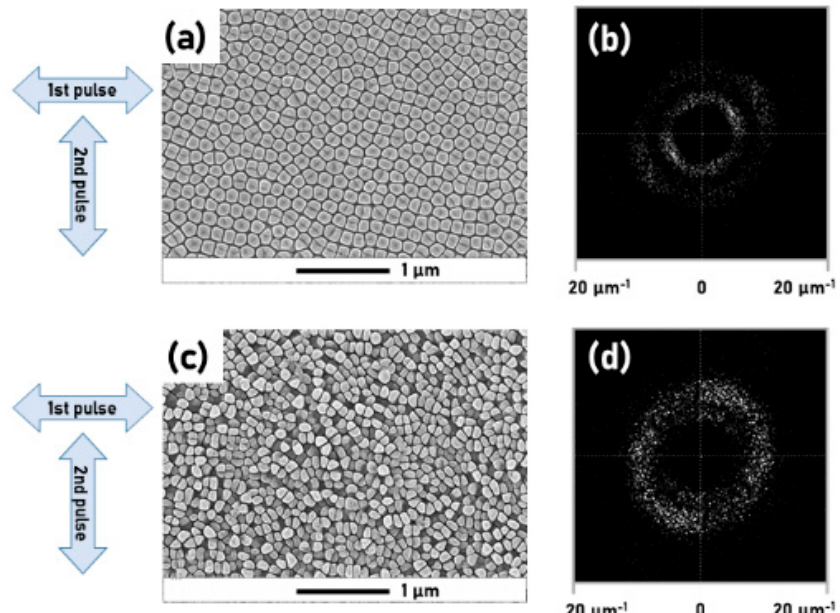
Figure 8. ( a ) SEM micrograph of 2D-LIPSS formed on the diamond surface after 40 double-laser pulses. ( b ) 2D − FFT of the SEM micrograph ( a ). ( c ) Formation of 2D − LIPSS on the diamond surface after 100 double-laser pulses. ( d ) 2D-FFT of the SEM micrograph ( c ). The arrows indicate the polarization directions of the first and second laser pulse. Reprinted with permission from Ref. [99]. Copyright © 2021 American Chemical Society.